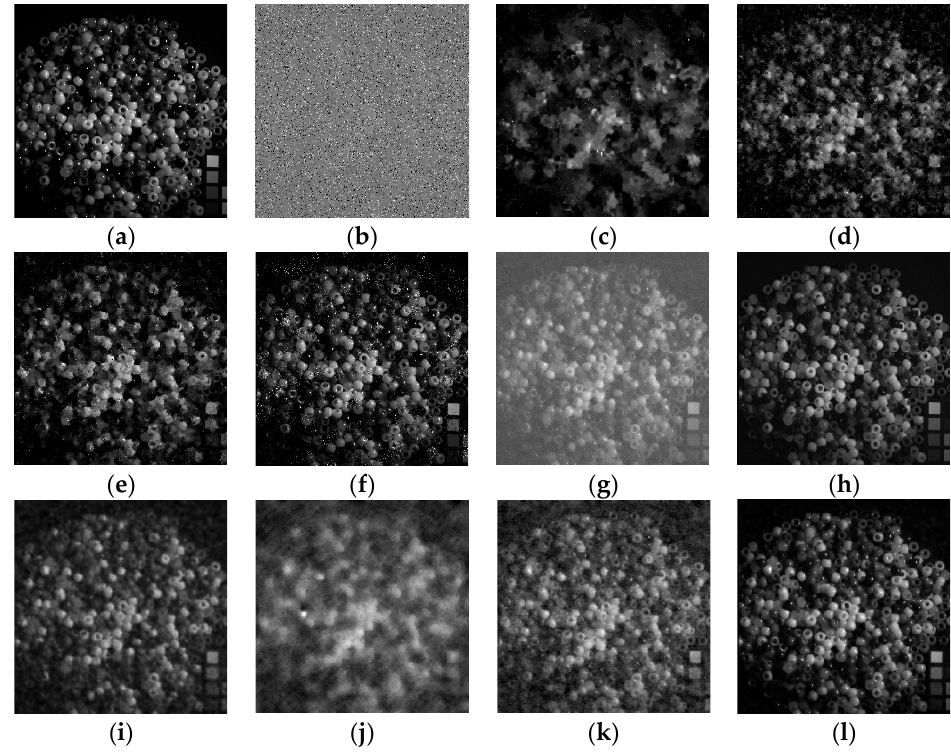
Figure 5. Restored images of band 27 corrupted with Gaussian noise, sparse noise and missing pixels: ( a ) clean HSI; ( b ) noisy HSI; ( c ) BM3D; ( d ) ANLM3D; ( e ) BM4D; ( f ) LRMR; ( g ) GLF; ( h ) LRTDTV; ( i ) LTDL; ( j ) DnCNN; ( k ) HSID-CNN; ( l ) VLRMFmcl.